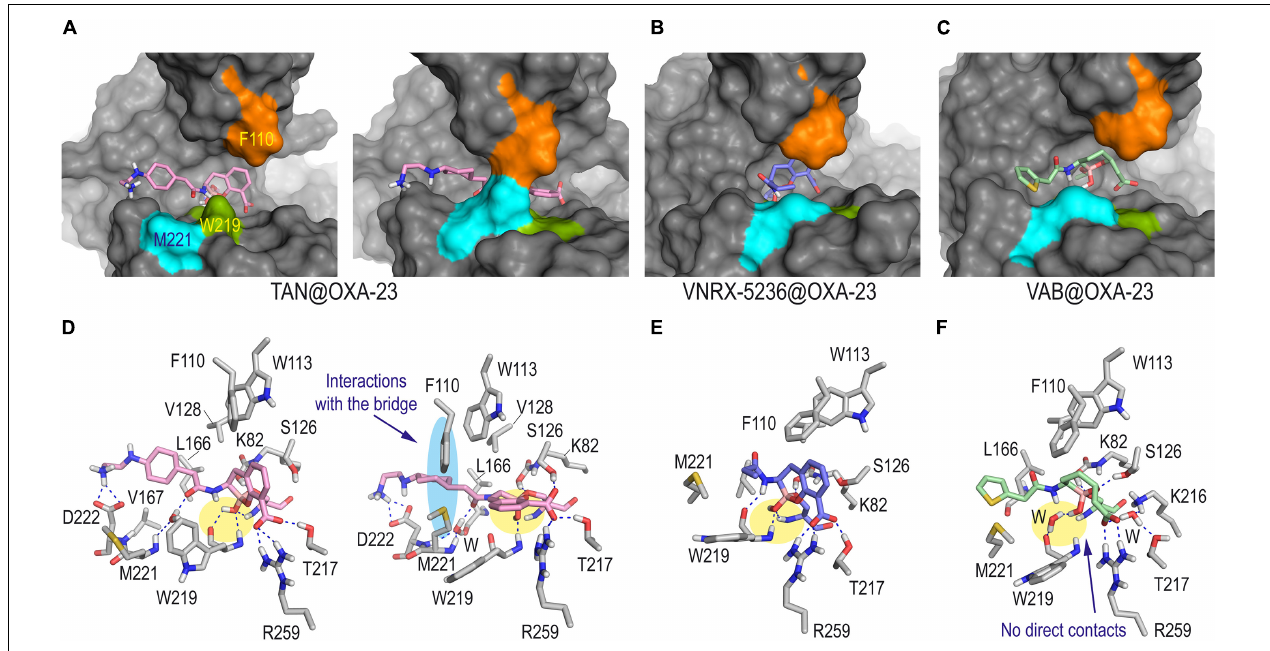
FIGURE 5 | Overall and detailed view of the covalent modification of OXA-23 by taniborbactam (A,D) , VNRX-5236 (B,E) , and vaborbactam (C,F) obtained by MD simulation studies. The residues involved in the tunnel-like entrance F110 (orange) and M221 (cyan) and the proximal conserved residue W219 (green) are highlighted in the surface representations. Relevant side chain residues are shown and labeled. Hydrogen bonding interactions are shown as blue dashed lines. For TAN@OXA-23 adduct, the two main poses observed during simulation in a 1:1 ratio are provided: one showing an open active site (snapshot @40 ns) and the second exhibiting the usual tunnel-like architecture (snapshot @80 ns). For the other adducts, snapshots taken after 90 ns of simulation are shown. The contacts of the boronate moiety are highlighted with a yellow shadow. Note how only taniborbactam would be partially surrounded by the hydrophobic bridge (highlighted with a blue shadow) when horizontal arrangement was achieved. Vaborbactam would be the only inhibitor that would not establish direct contacts with the main backbone of OXA-23. TAN, taniborbactam; VAB,